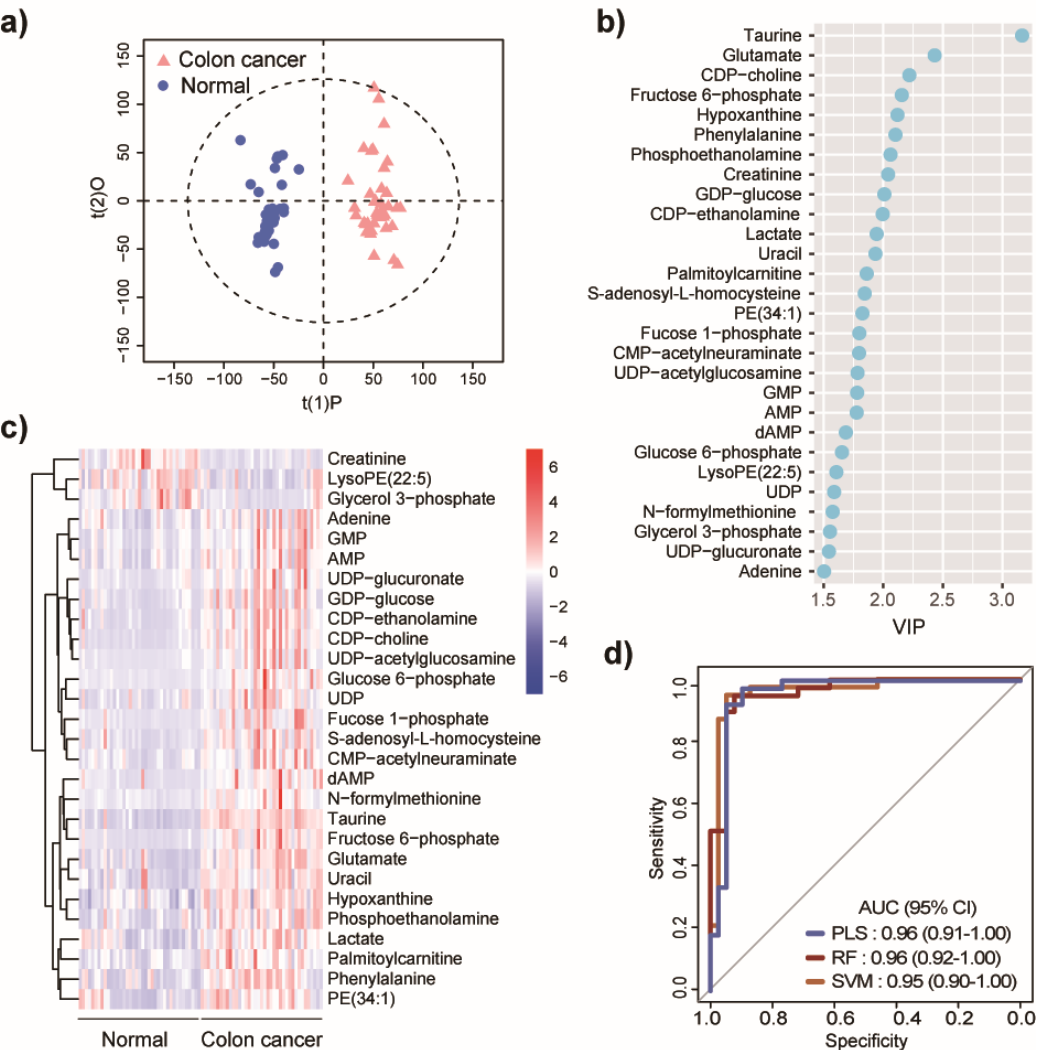
Figure 1. Metabolic differences in colon cancer revealed by untargeted metabolome profiling. ( a ) Orthogonal partial least-squares discriminant analysis (OPLS-DA) scores plot assessing variance of features between normal colon and colon tumors ( n = 39/group). Dotted circle in the plot indicates the 95% confidence interval. For the OPLS-DA model, R 2 Y = 0.96, Q 2 = 0.77. ( b ) The 28 identified metabolites from OPLS-DA analysis ranked by variable importance in the projection (VIP) values. ( c ) Heatmap showing significantly different expression levels of metabolites in cancer (vs. normal , n = 39) colon tissues ( n = 39). Scale is z-score. ( d ) Receiver operating curve (ROC) plots of predictive models, based on 28 metabolic biomarkers, using partial least-squares (PLS), random forest (RF), and support vector machine (SVM), respectively.